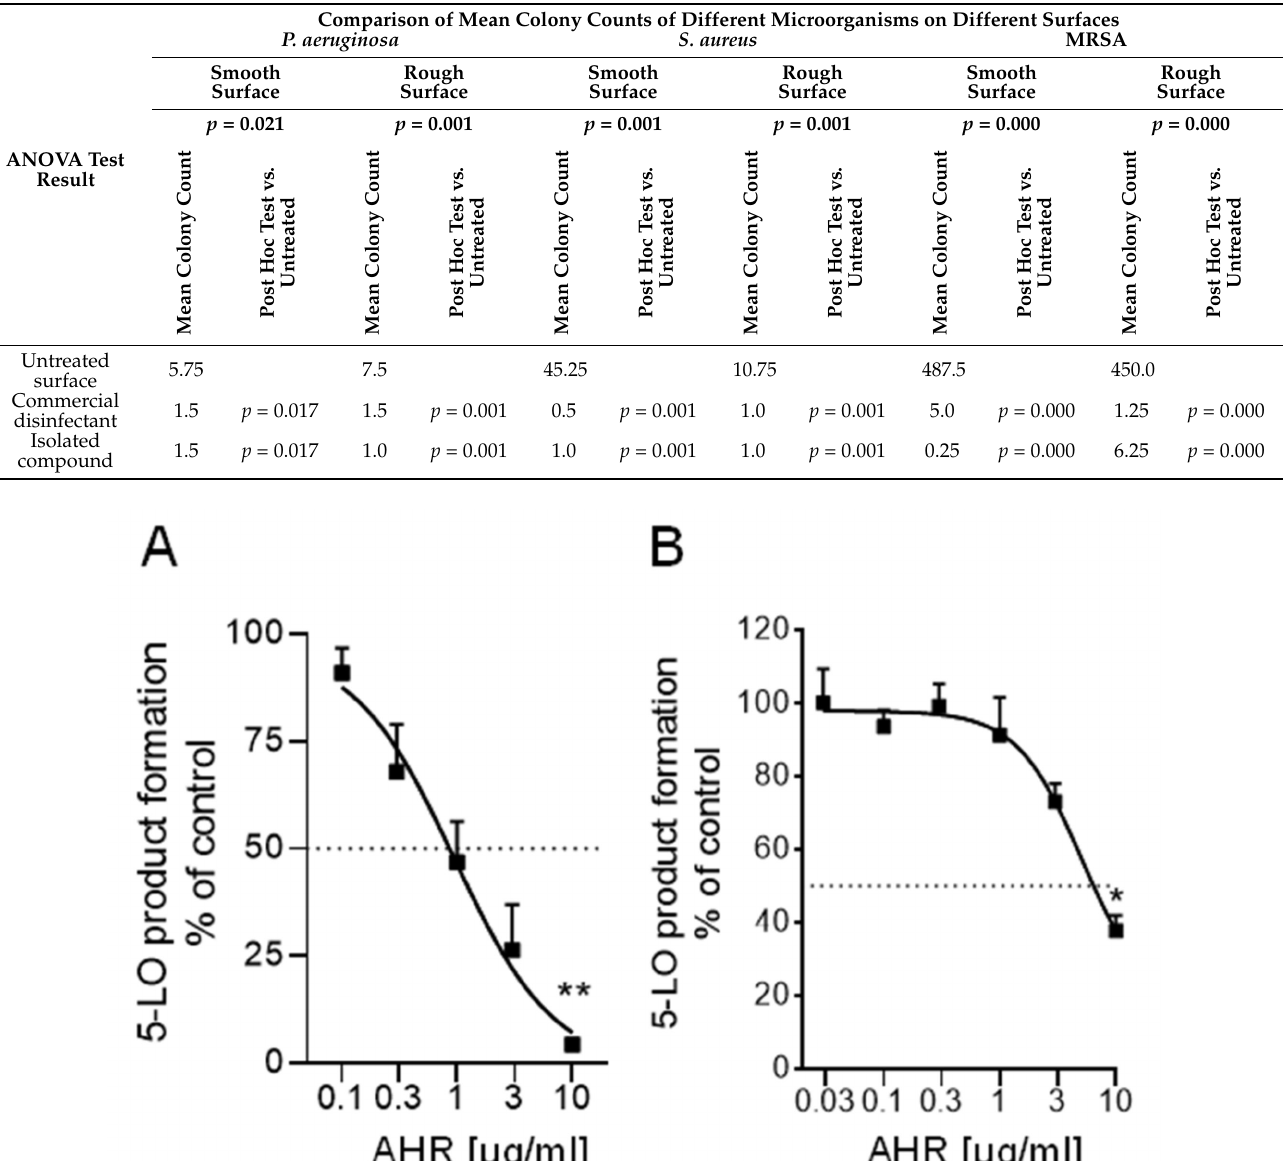
Table 4. Comparison of mean colony counts of different microorganisms on different surfaces by one-way ANOVA with post hoc multiple comparisons.